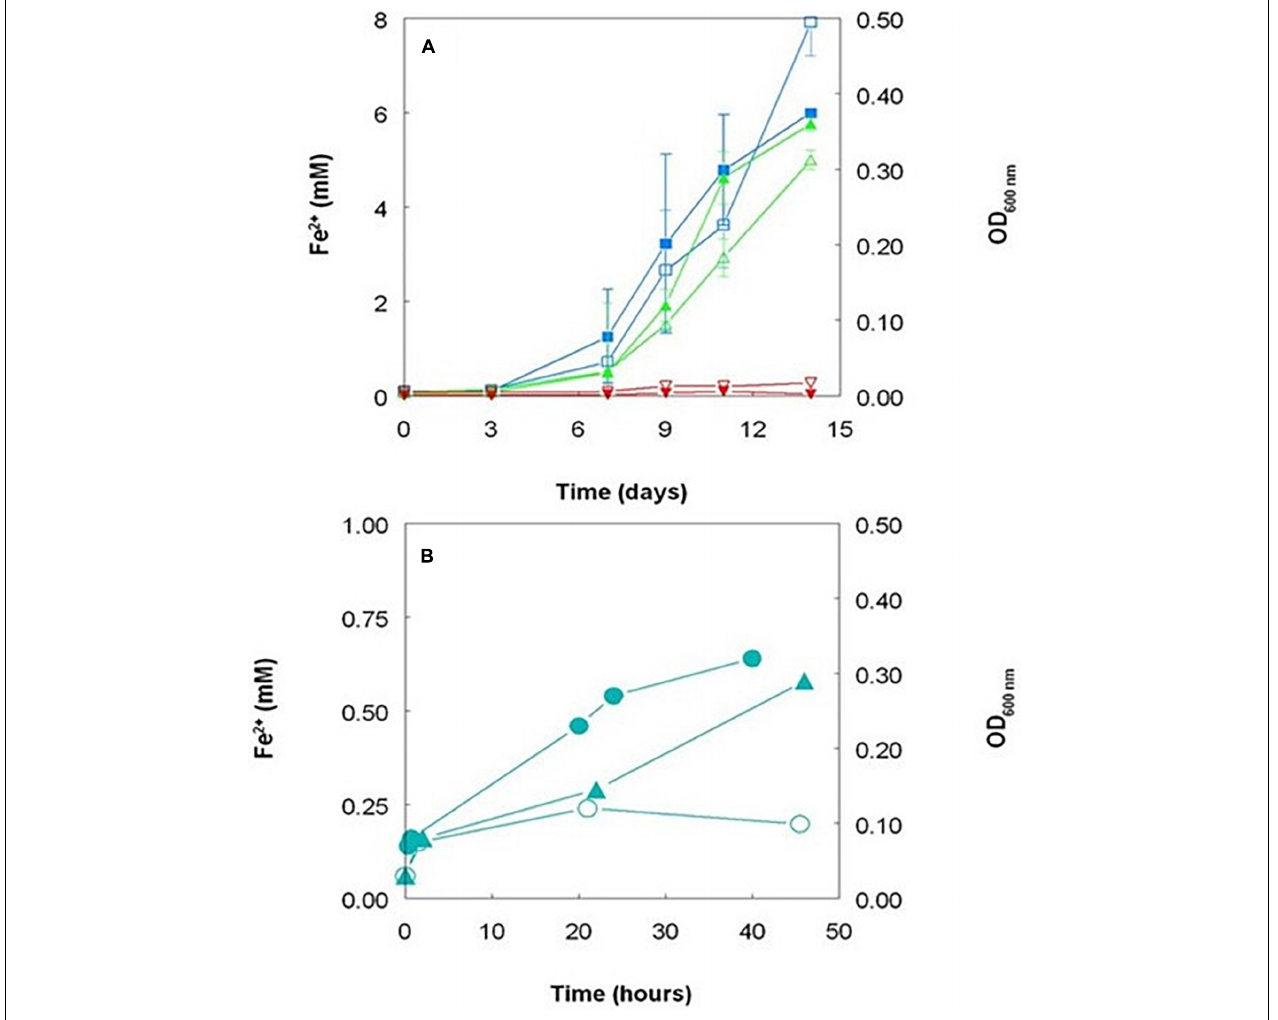
FIGURE 6 | (A) Changes in concentrations of ferrous iron (filled symbols) and culture optical densities at 600 nm (hollow symbols) in aerobic cultures of Acidithiobacillus thiooxidans DSM 103717 grown at pH 2.0 ( (cid:4) , (cid:3) ), 1.5 ( (cid:78) , (cid:49) ), and 1.0 ( (cid:72) , ∇ ); (B) changes in concentrations of ferrous iron in harvested and washed cell suspensions of Acidithiobacillus thiooxidans DSM 103717 grown on hydrogen ( ) or ZVS ( (cid:78) ), and by heat-killed cell suspensions grown on hydrogen (o). The hydrogen-grown suspensions contained ca. 8.5 × 10 8 cells mL − 1 and the ZVS-grown suspensions ca. 5.2 × 10 8 cells mL − 1 (cid:32)